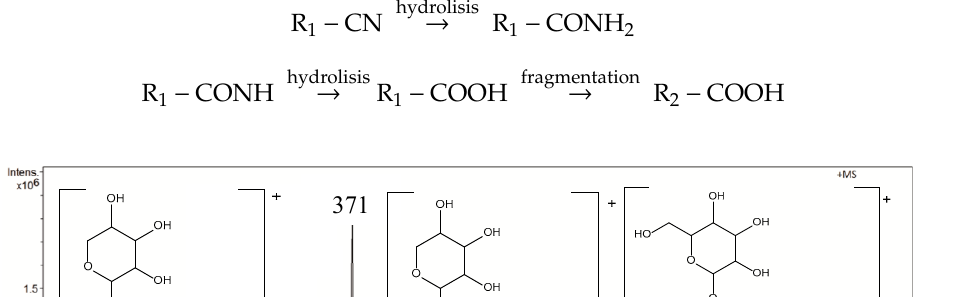
Figure 8. The positive mode FAPA-MS spectrum of amygdalin in 45 mg L -1 aqueous solution.